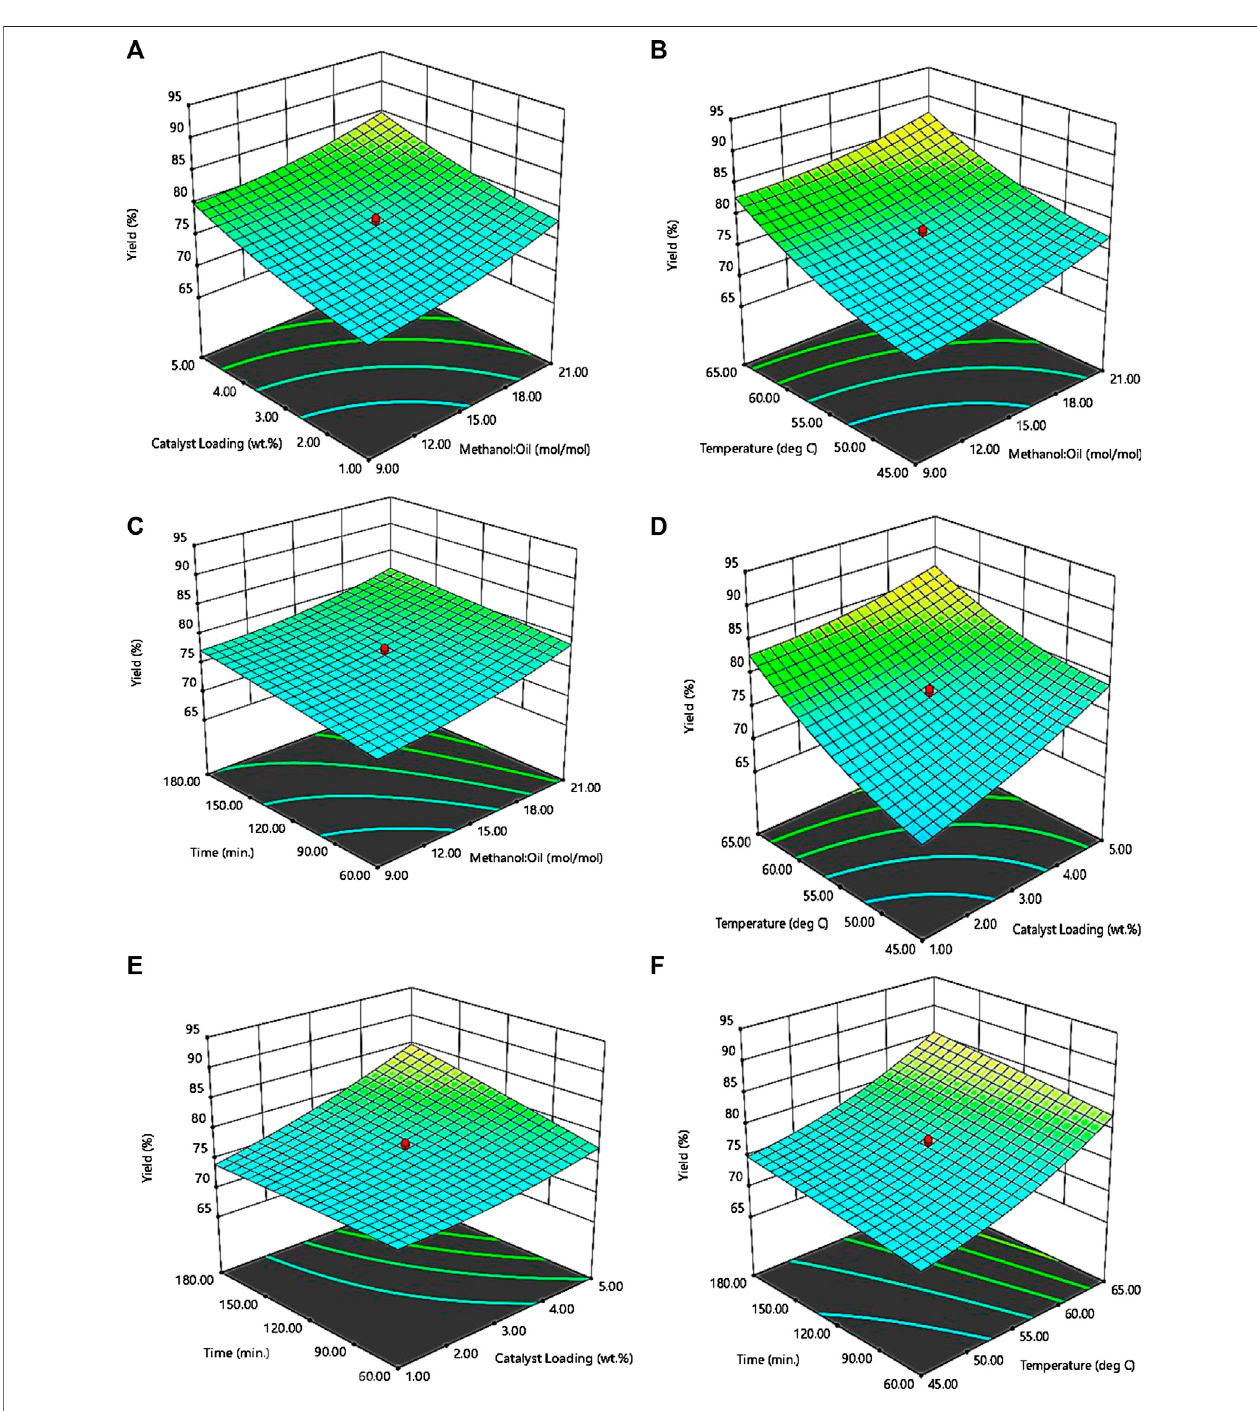
FIGURE 5 | Response surface plots for biodiesel yield as a function of (A) methanol: oil and catalyst loading (B) methanol: oil and reaction temperature (C) methanol: oil and reaction time (D) catalyst loading and reaction temperature (E) catalyst loading and reaction time (F) reaction temperature and reaction time.